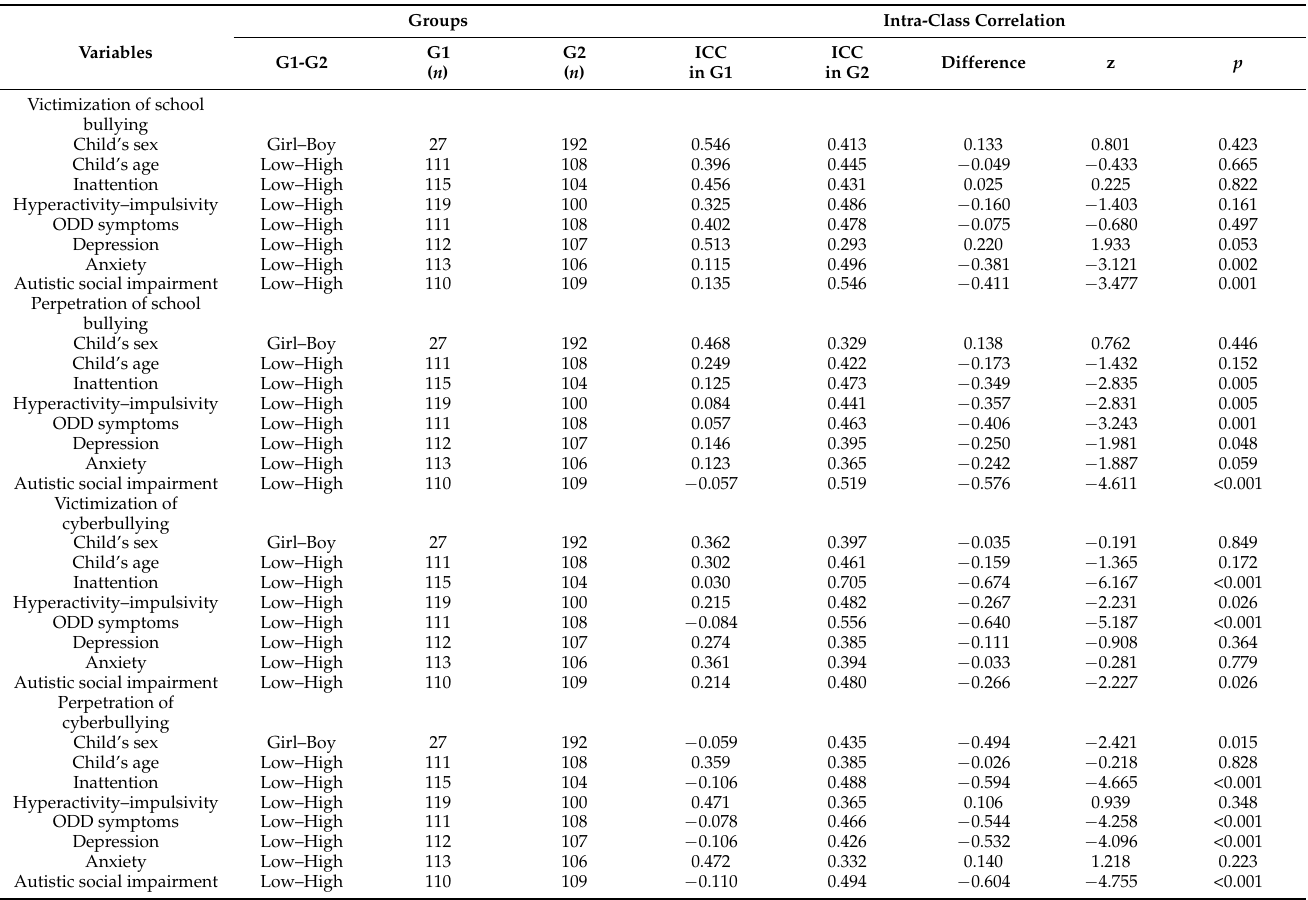
Table 3. Differences among various groups of adolescents with autism spectrum disorder regarding levels of adolescent–caregiver